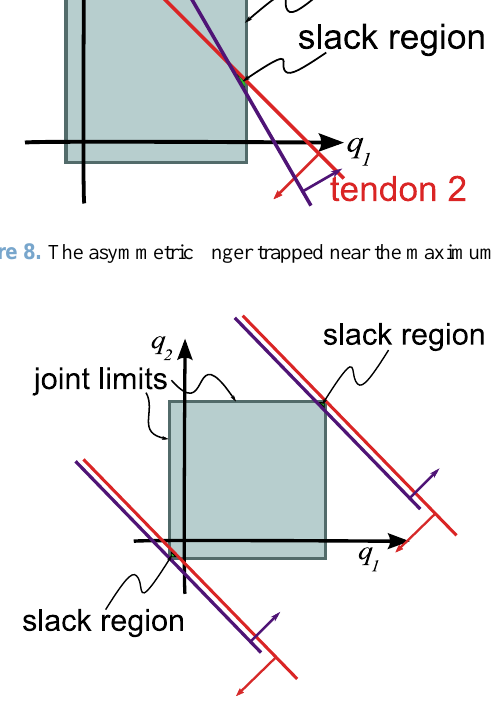
Figure 9. The symmetric finger is stable only at full flexion or full